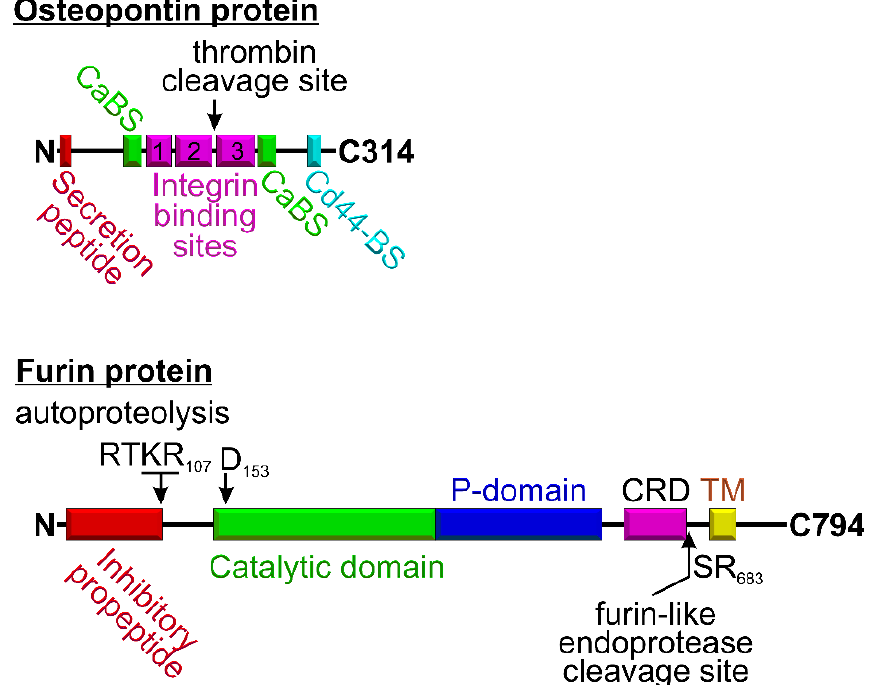
Figure 2. Block diagrams of the osteopontin and furin proteins. Osteopontin contains an N ‐ terminal “secretion peptide” responsible for targeting the protein to the secretory pathways. Osteopontin is subject to thrombin ‐ mediated cleavage, which is critical for exposing the SVVYGLR ‐ integrin binding site. The furin protein is a proprotein convertase that may be membrane bound or shed. The catalytic domain of furin is shown in green. The D153 residue of furin is important for its catalytic activity. In the furin block diagram, there is an N ‐ terminal “inhibitory propeptide” that is blocking the catalytic activity of furin even after autoproteolytic cleavage and needs to be degraded to make furin functionally active; the P ‐ domain stands for the regulatory proprotein convertase domain; TM stands for transmembrane domain; and CRD stands for cysteine ‐ rich domain. The SR683 residues were shown to serve as the proteolytic site for furin shedding.